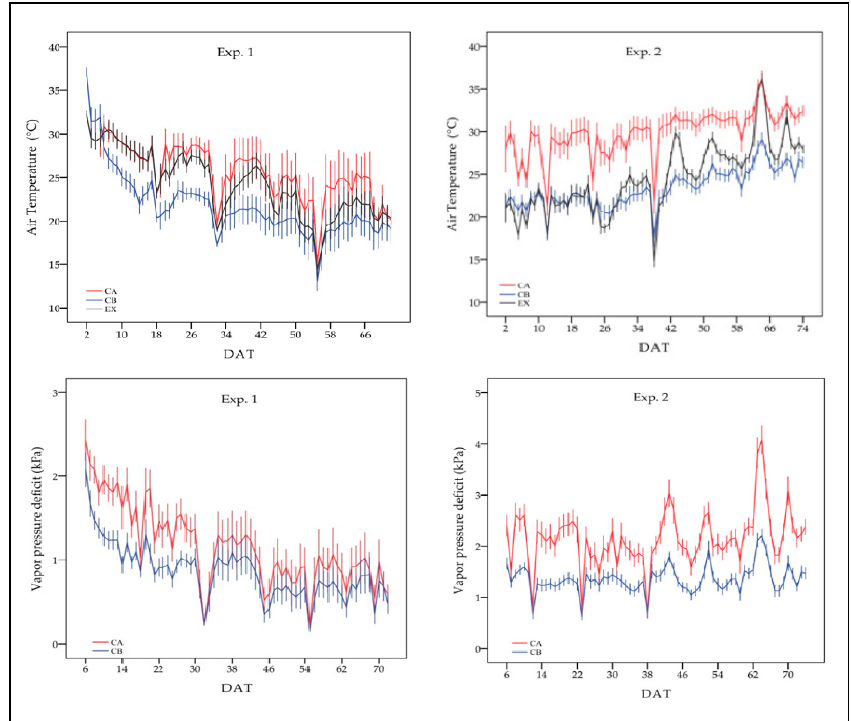
Figure 3. Mean measured greenhouse air temperature and vapor pressure deficit in the greenhouse compartment with fan ventilation cooling system (CA) and in the greenhouse compartment with fan-pad evaporative cooling (CB) during Exp. 1 and Exp. 2; ambient air temperature (EX); error bars (± 1 standard error).